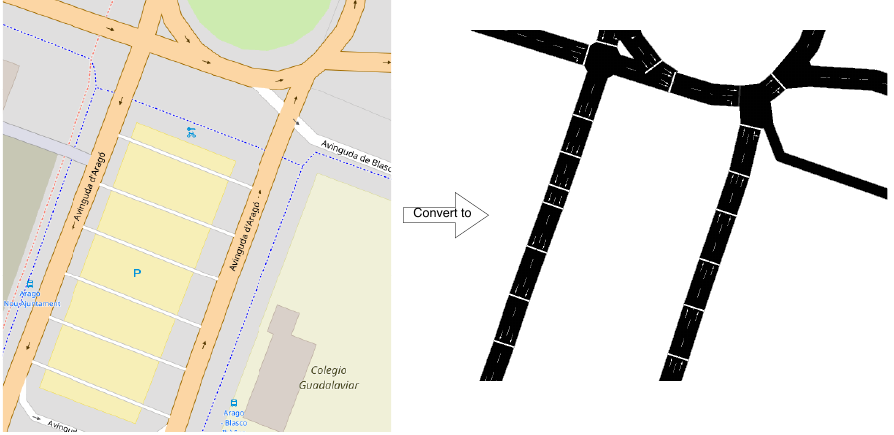
Figure 2. Example of unnecessary street